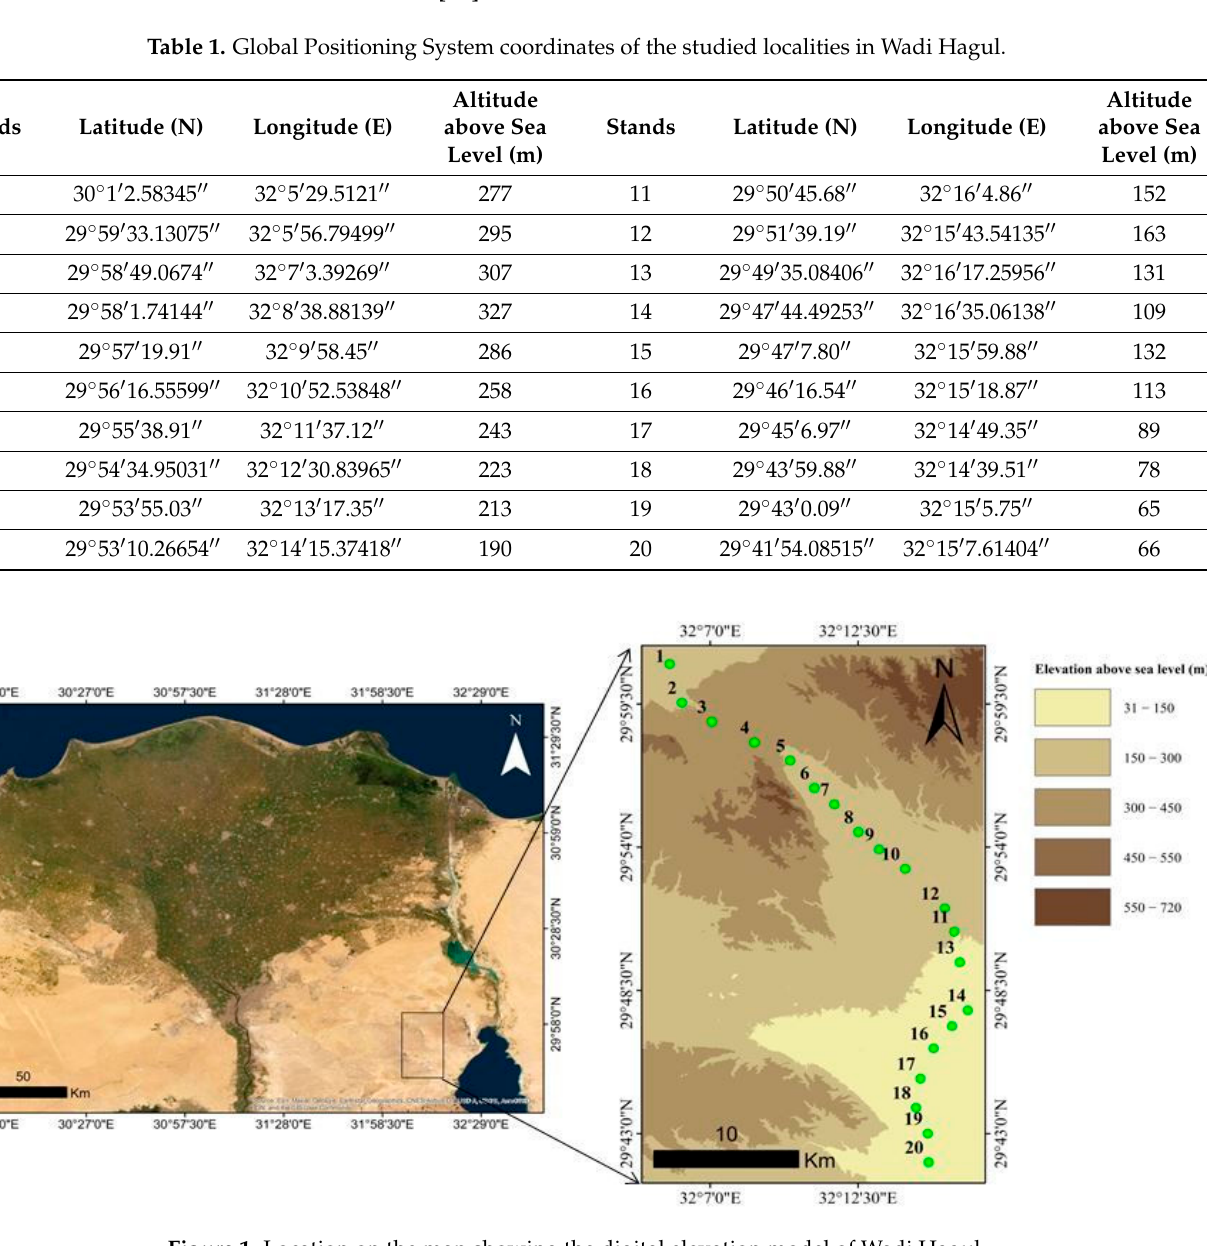
Figure 2. A quadrate with an area of 10 meters × 10 meters in. 10 meter